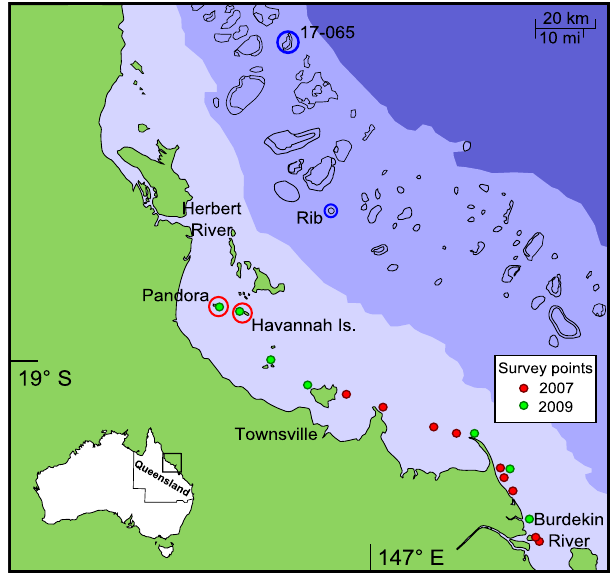
Figure 1. Map of the central area of the GBR showing locations of water sample and coral core collection sites: Pandora Reef and Havannah Island in the inner shelf, Rib Reef and 17-065 Reef in the mid-shelf region, and water sample collection sites during the flood events of 2007 and